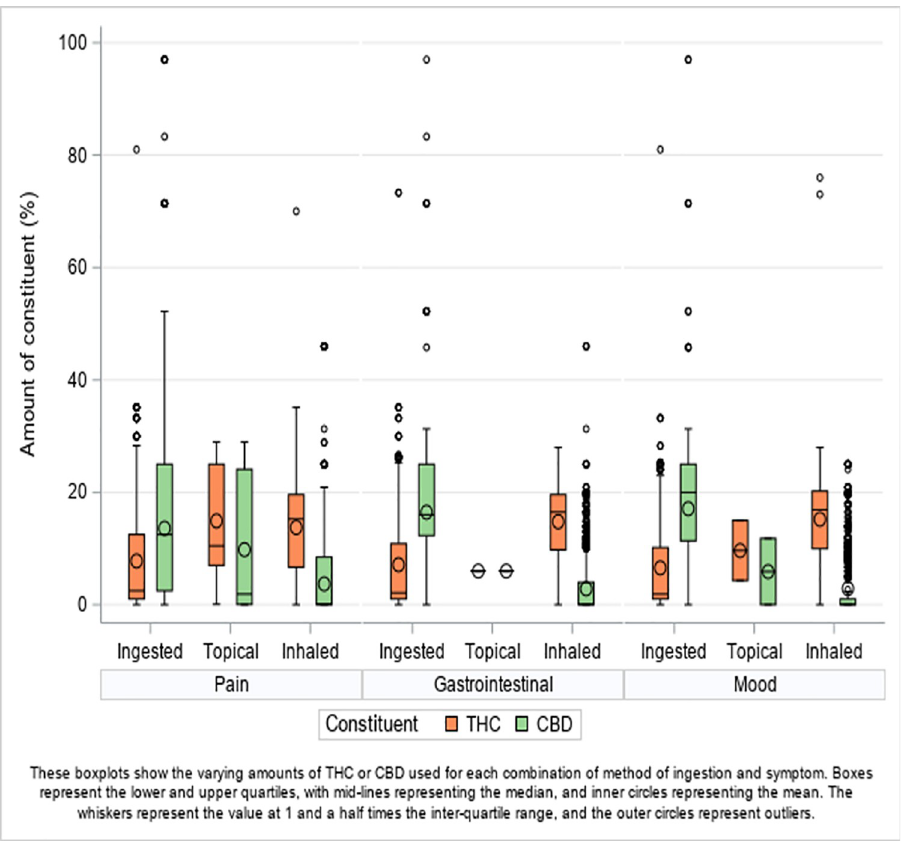
Fig 1. THC and CBD by symptom group and ingestion